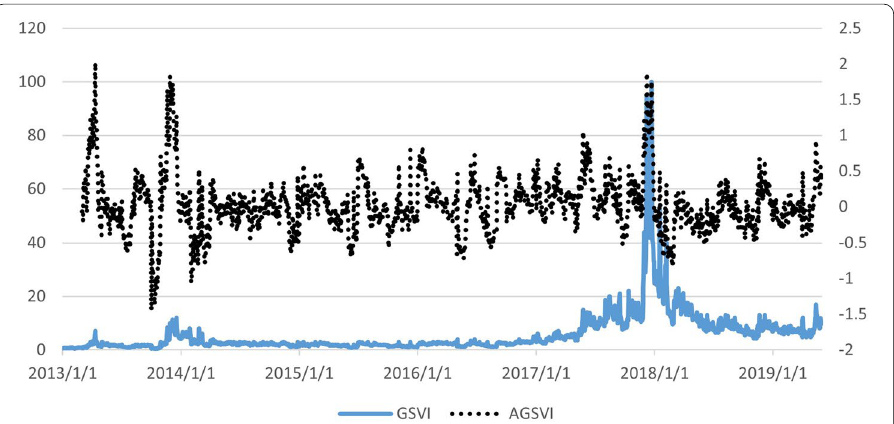
Fig. 2 Daily GSVI (left axis) and AGSVI (right axis) with search term